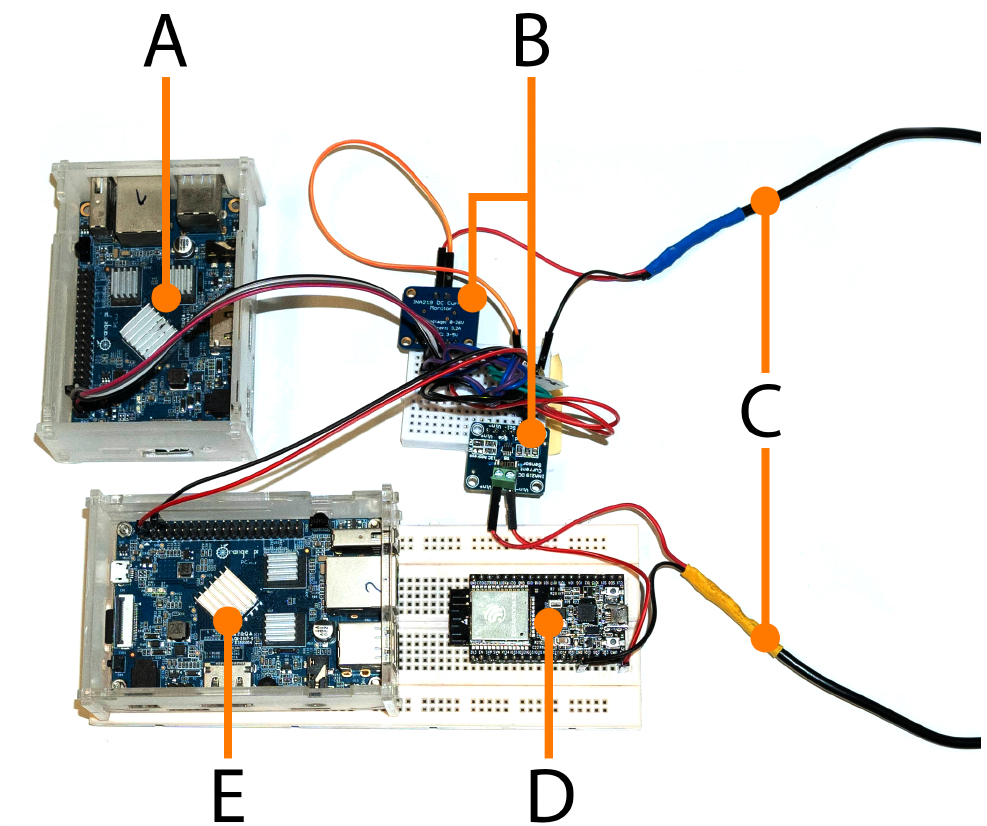
Figure 4. Main components of the testbed. ( A ) Orange Pi PC for performing energy measurements; ( B ) INA219 current sensors; ( C ) 5 V power supply; ( D ) ESP32 (mist end-device); ( E ) Orange Pi PC (fog